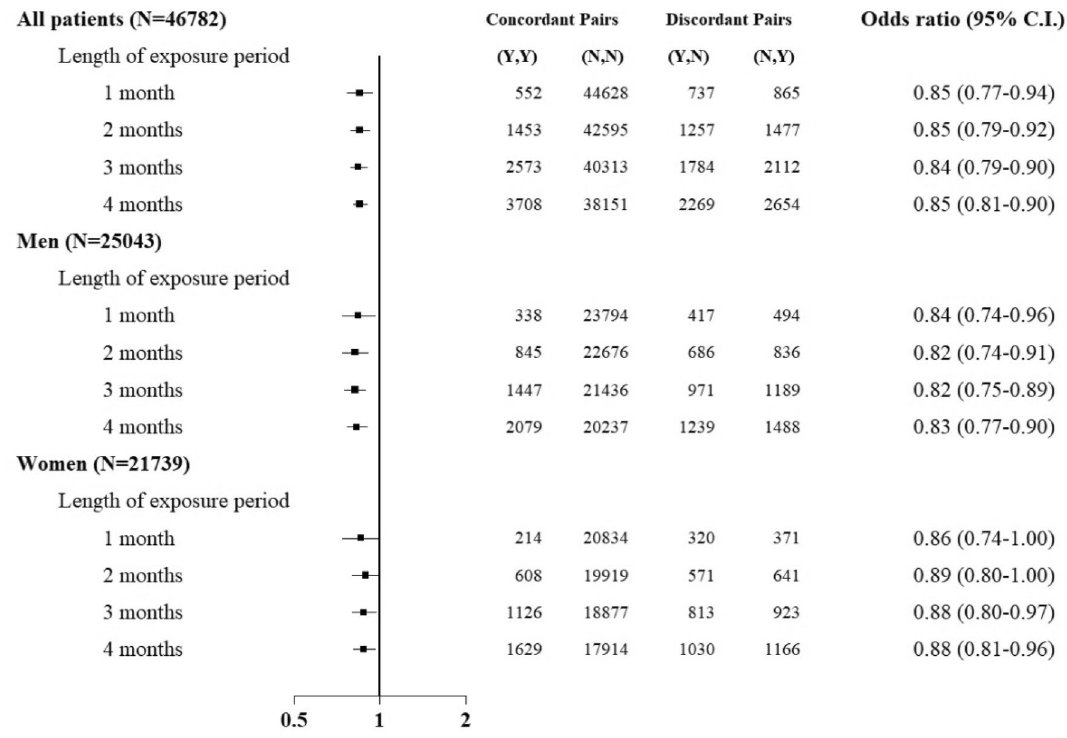
Figure 2. ORs for incident PAOD after influenza vaccination in patients with CKD when the control was selected from 1 year before PAOD. CKD chronic kidney disease, PAOD peripheral arterial occlusive disease, ORs odds